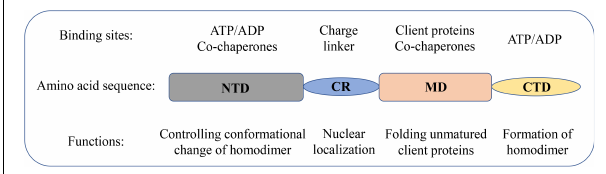
FIGURE 1 | Domain structure of Hsp90 family members in humans. Schematic representation of the domain structure of Hsp90 isoforms together with the biological functions of each